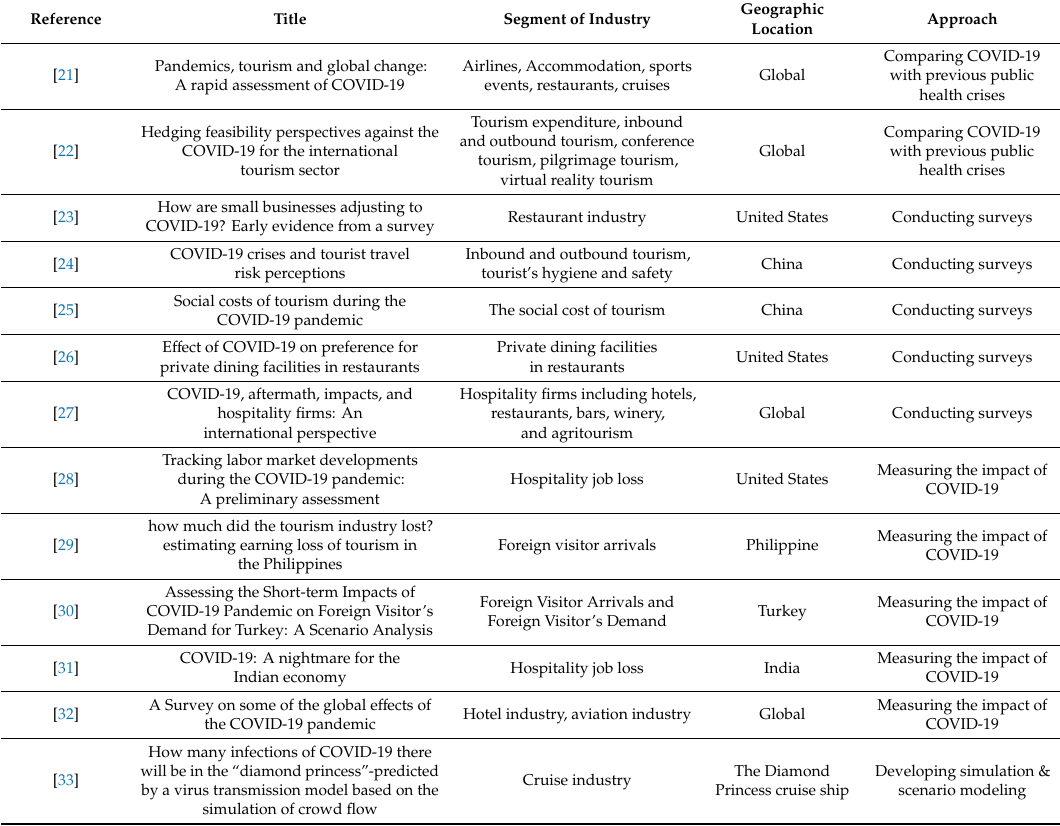
Table 2. Characteristics of the included papers.